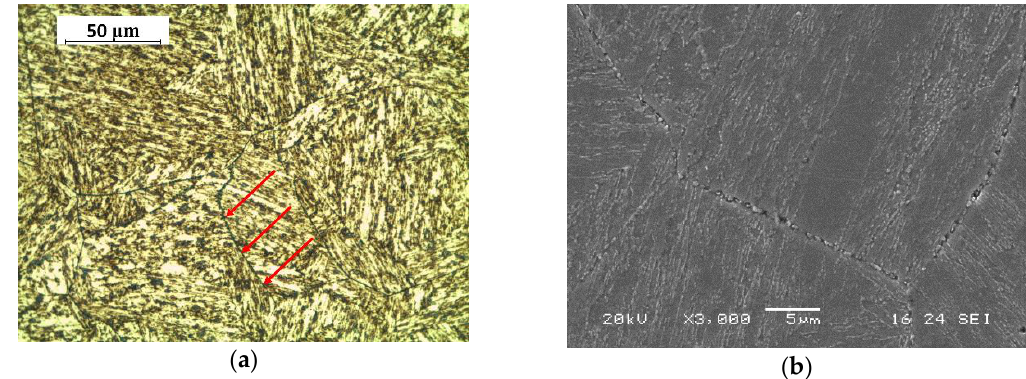
Figure 1. ( a ) Light microscope image (red arrows indicate carbides) and ( b ) SEM image of group I steel microstructure.